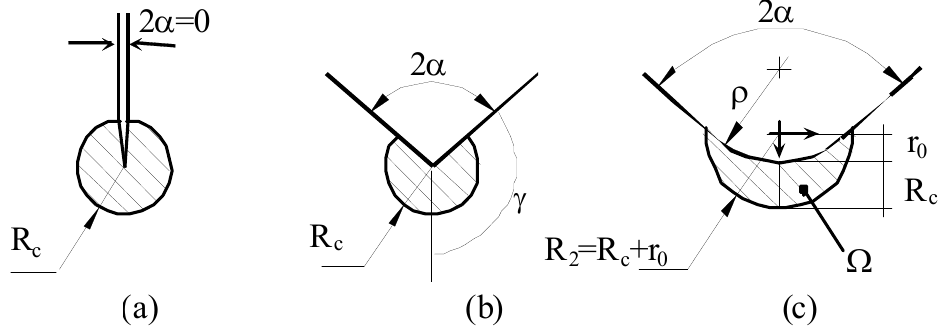
Figure 2: Control volume for (a) crack, (b) sharp V-notch and (c) blunt V-notch, under mixed mode I+III